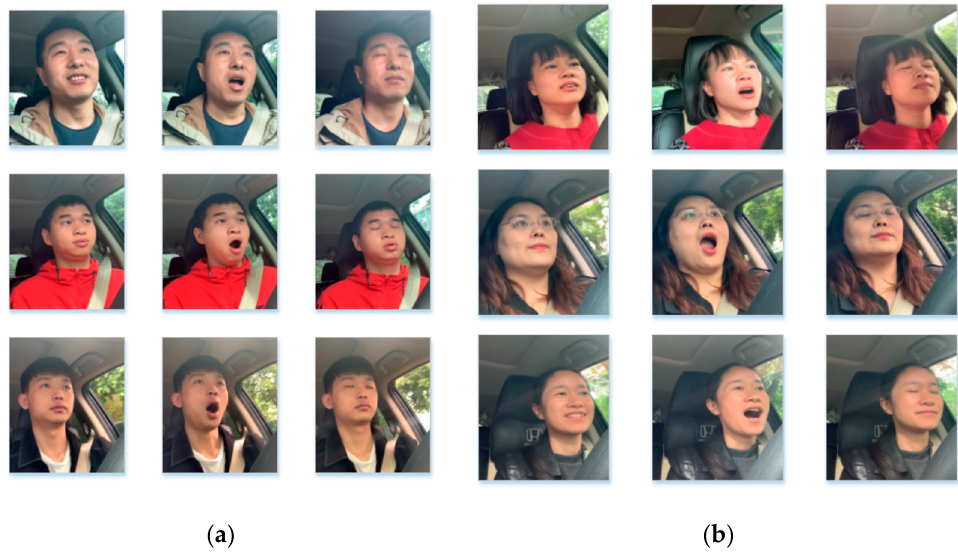
Figure 8. SBD dataset. (a) Images of male drivers. (b) Images of female drivers.